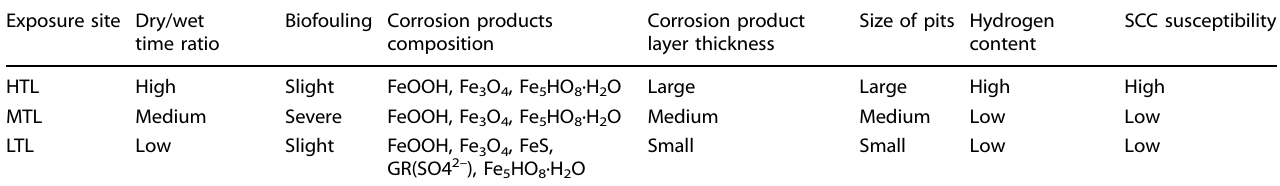
Table 4. Main differences between the external environment and corrosion, hydrogen permeation, and SCC behaviours of the AISI 4135 steel samples at different locations in the tidal